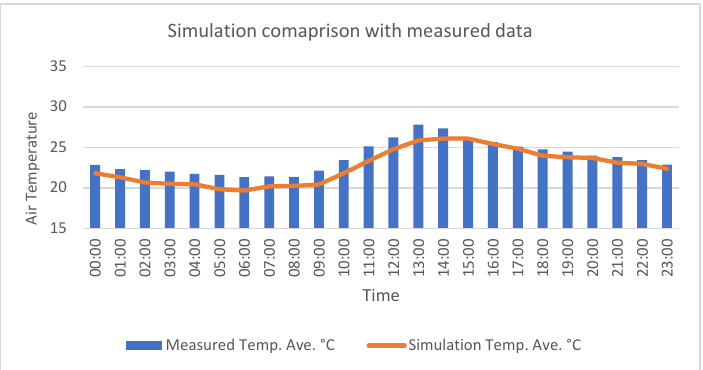
Time Measured Temp. Ave. °C Simulation Temp. Ave. °C Figure 3. Air temperature simulation result of the selected area in Al Taawun at 2:00 pm. (Image generated by ENVI-met). Figure 4. Measured and simulated air temperature in Al Taawun on 11 February 2022.